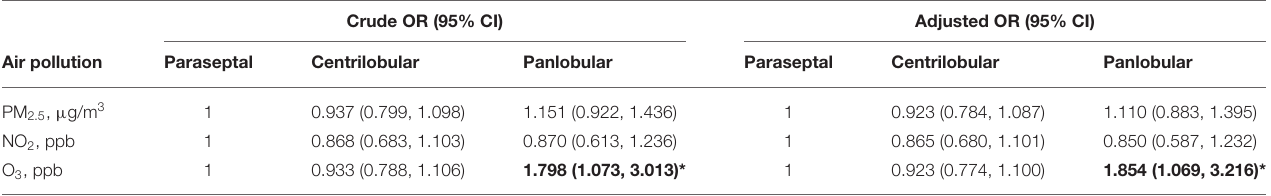
TABLE 2 | Associations [odds ratio (OR)] of centrilobular and panlobular emphysema subtypes with paraseptal emphysema (reference) by 1-year average air pollution concentrations of PM 2.5 , NO 2 , and O 3